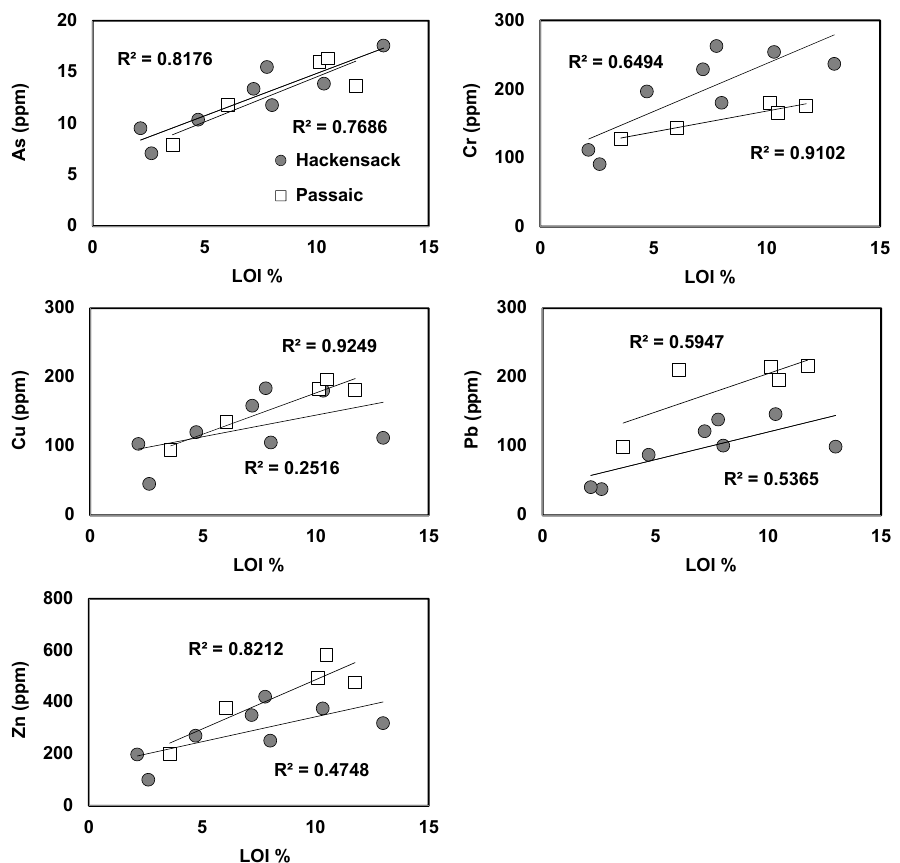
Figure 8. Correlations between LOI % (Loss on Ignition %; sediment organic matter content) and concentrations of heavy metals in sediments (<2 mm grain size) collected from the Hackensack and Passaic Rivers in summer 2015.